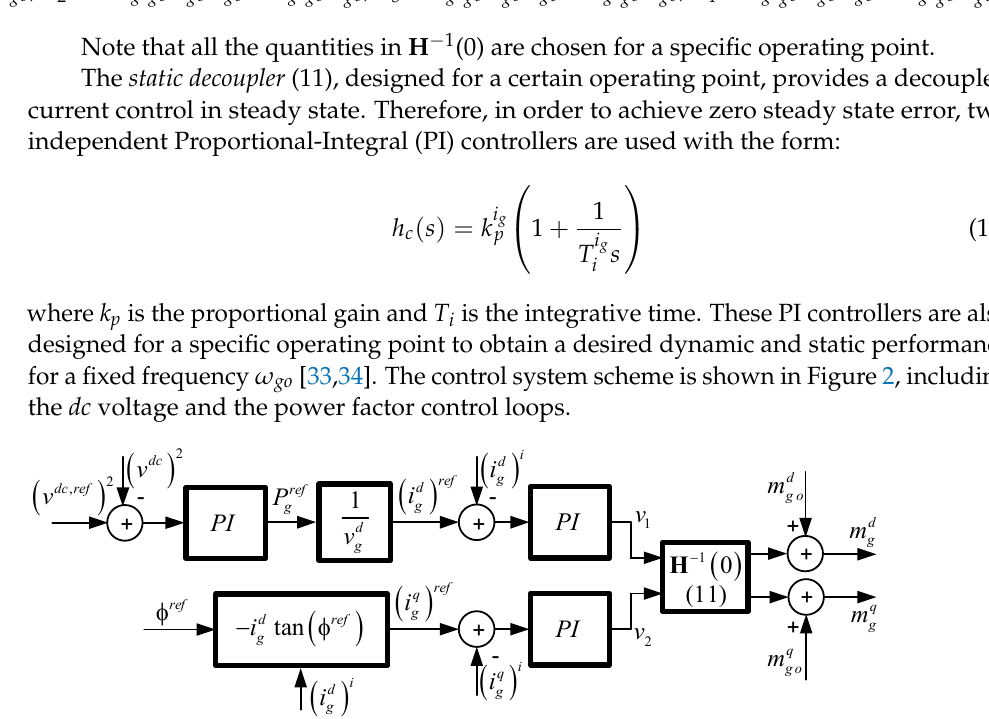
Figure 2. Power converter rectifier with a static decoupler control.